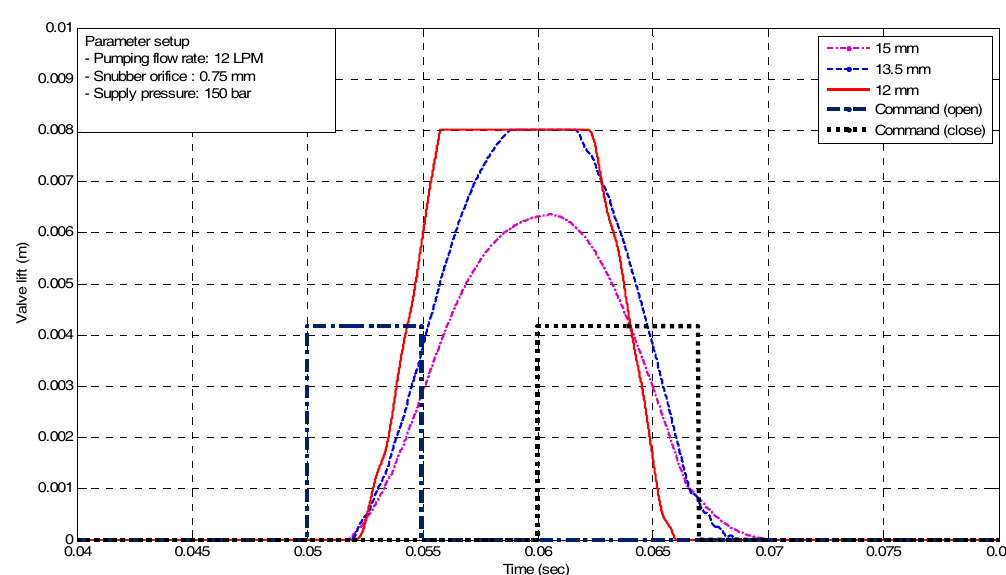
Sensors 2017 , 17 , 2940